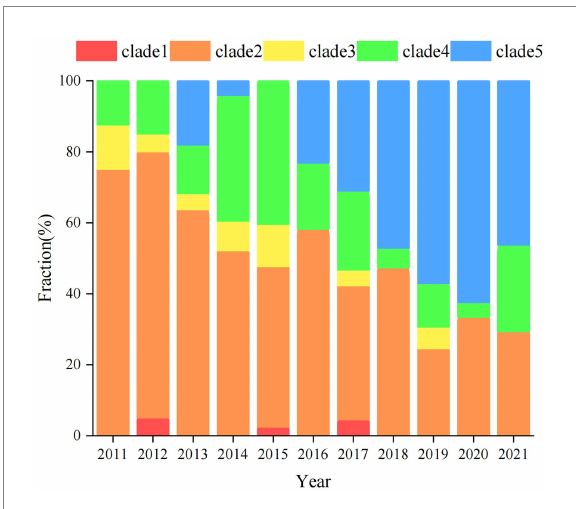
FIGURE 2 Distribution of S. Derby ST40 evolutionary branches globally. Different strip colors indicate different clades, clade1 (red), clade2 (orange), clade3 (yellow), clade4 (green), and clade5